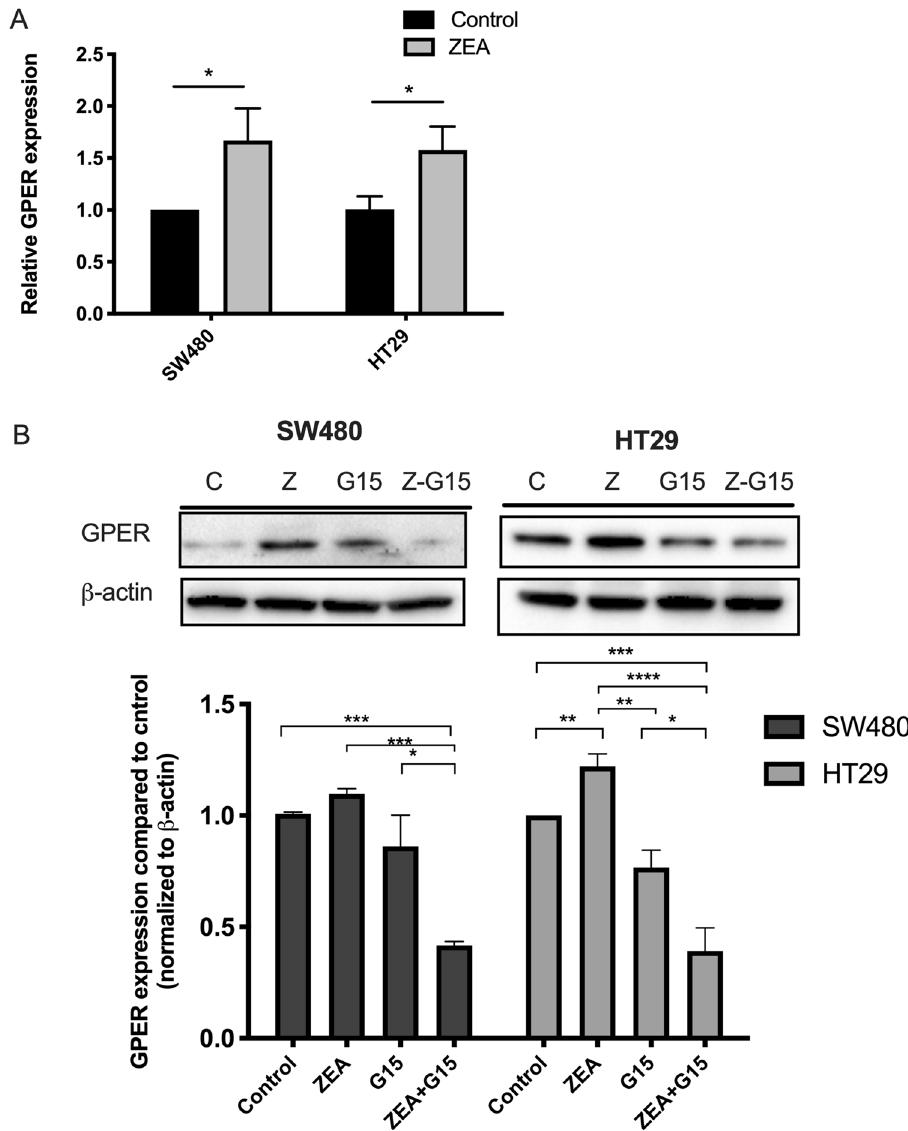
Figure 2. ZEA increases GPER expression in CRC cell. ( A ) RT-qPCR analysis of GPER gene expression in SW480 and HT29 cells with and without 3 μM ZEA was investigated. ( B ) Western blot analysis of GPER in SW480 and HT29 with and without G15 treatment was investigated. Results shown are mean ± SEM, with n = 3. *p < 0.05, **p < 0.01, ***P < 0.001 and ****p <